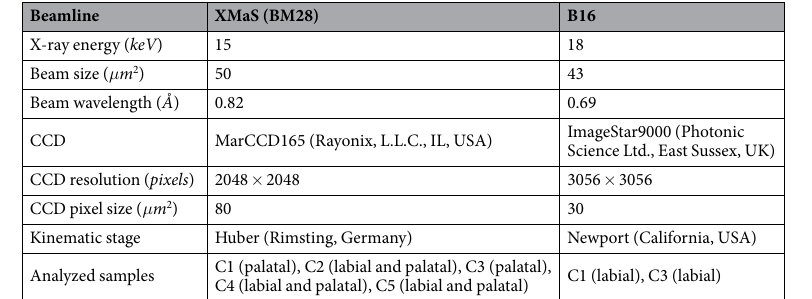
Table 1. The experimental parameters used at XMaS and B16 beamlines at ESRF and DLS,